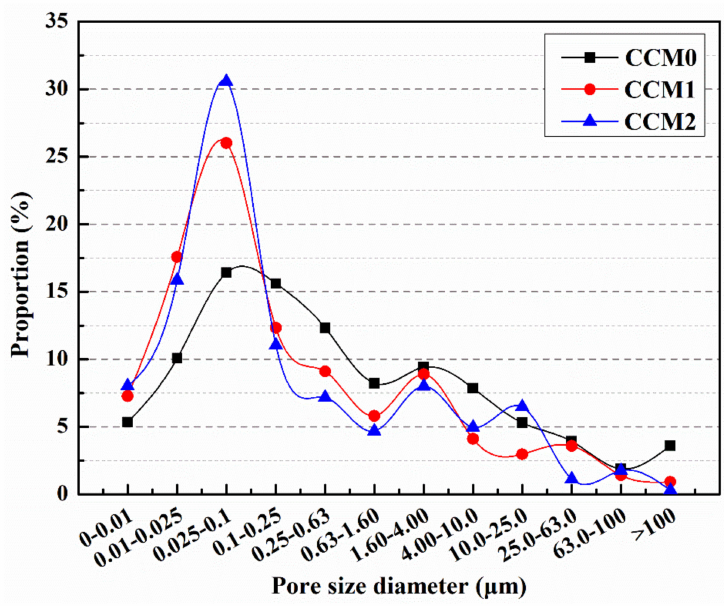
Figure 11. Pore size distribution of mortars after 14 days of self-healing.